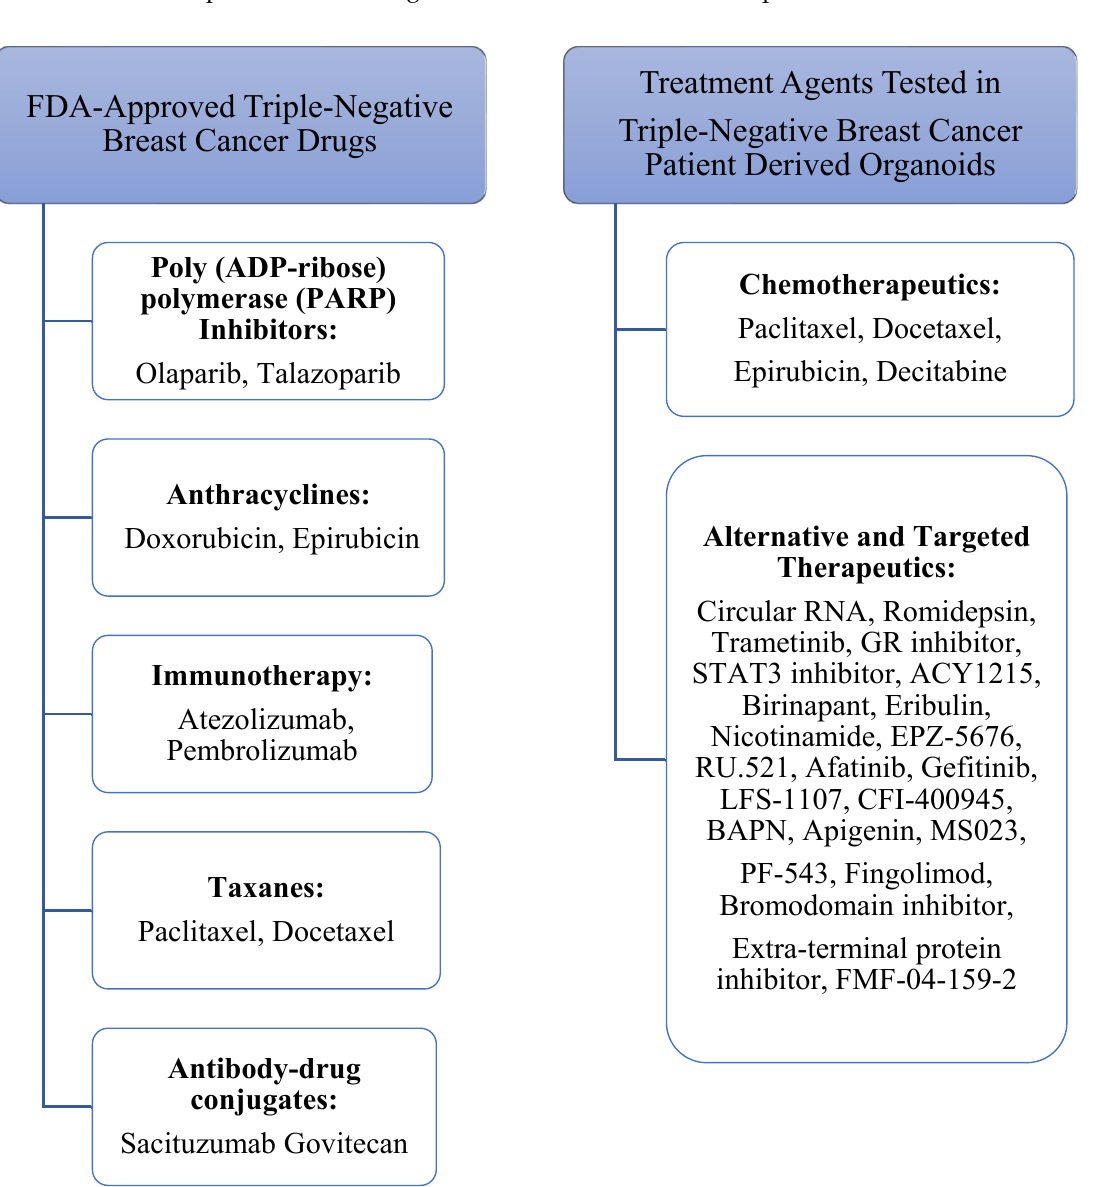
Figure 2. Current FDA-approved treatment agents for TNBC versus the drugs tested in and specific to TNBC patient-derived organoids.